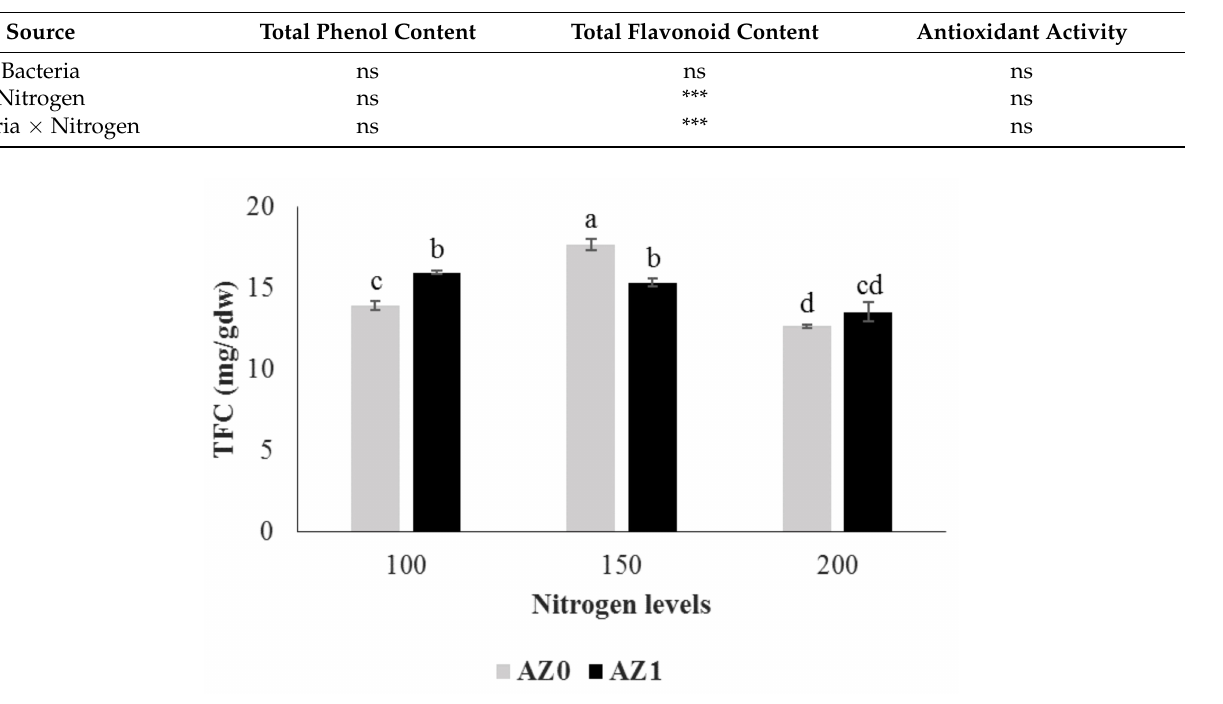
Figure 4. Total flavonoid content (TFC) in hydroponically grown lettuce influenced by Azotobacter under different nitrogen levels. The letters indicate the mean comparison using LSD test ( p < 0.05) which was implemented for examining the differences among the